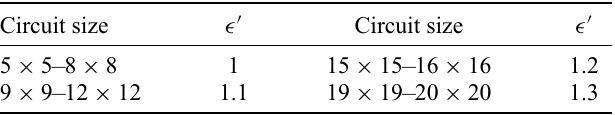
TABLE I. Error rate parameter (cid:8) (cid:7) used for various size circuits. Circuit sizes of n qubits and N layers are represented in shorthand notation as n × N